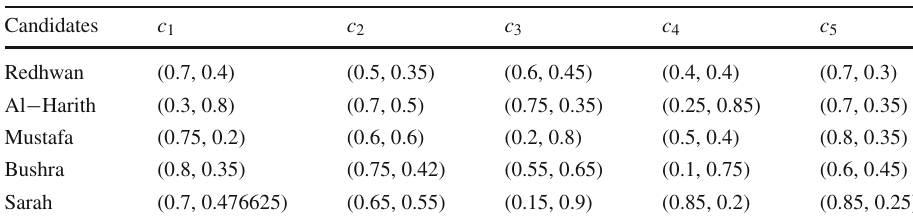
Table 1 (2,1)-Fuzzy numbers